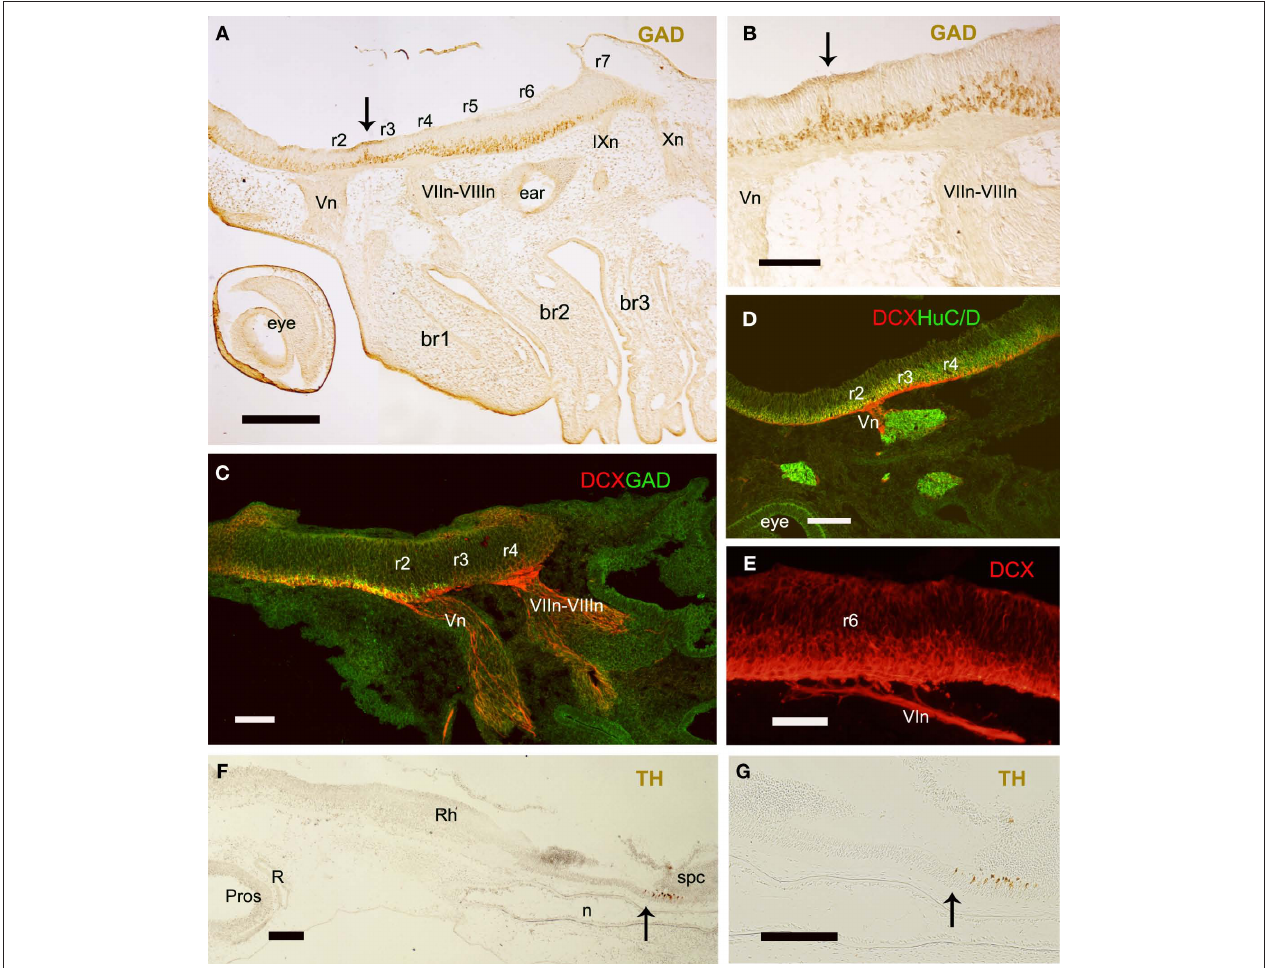
labeled processes at the roots of V (C,D) , VII–VIII (C) , and VI (e) nerves. (F,g) Panoramic view and detail showing the rostral extension of the spinal TH-ir CSF-contacting neurons. Arrows indicate the possible rhombencephalon–spinal cord boundary. For abbreviations, see list.